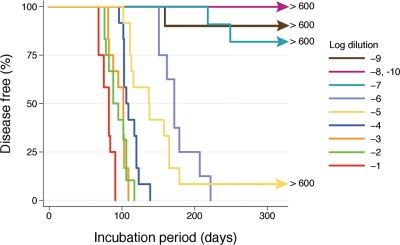
Kaplan-Meier survival curves for serially diluted 301V prions bioassayed in Tg(MoPrP-B)2091/Prnp
0/0 mice.Three independent 10% brain homogenates were serially diluted 10-fold and each inoculated into 4 mice, which were then monitored for clinical symptoms of prion disease. No significant differences were observed among the three dilution series and the data were therefore combined. Incubation period is the number of days from inoculation to manifestation of clinical symptoms. Mice with intercurrent illnesses were censored at the time of euthanasia.